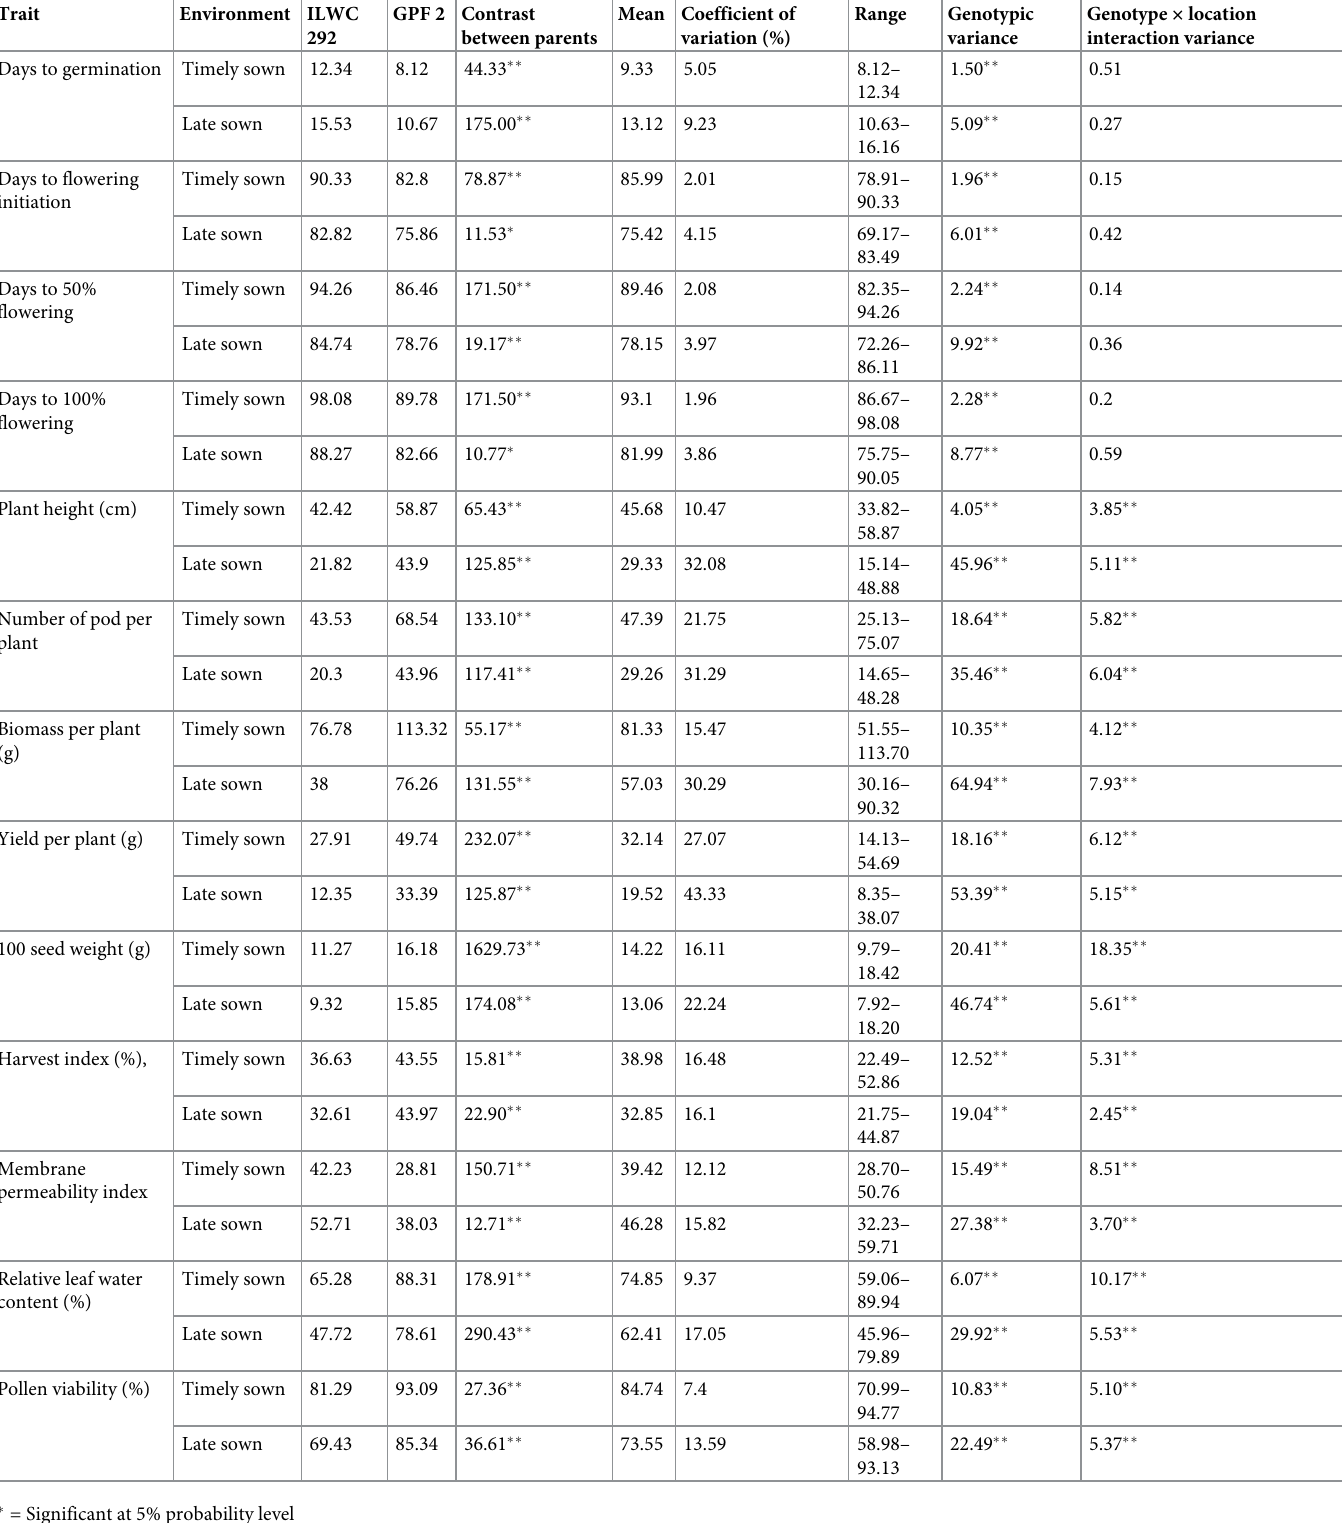
GPF 2 Contrast Mean Coefficient of Range Genotypic Genotype × location 292 between parents variation (%) variance interaction variance